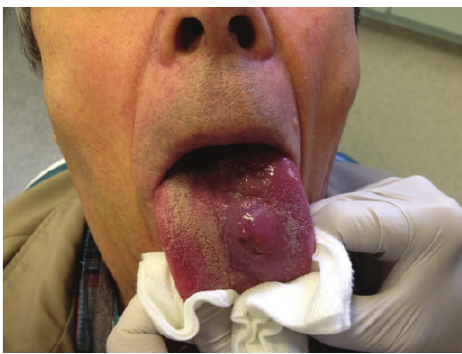
Figure 1: Presentation of tongue lesion.